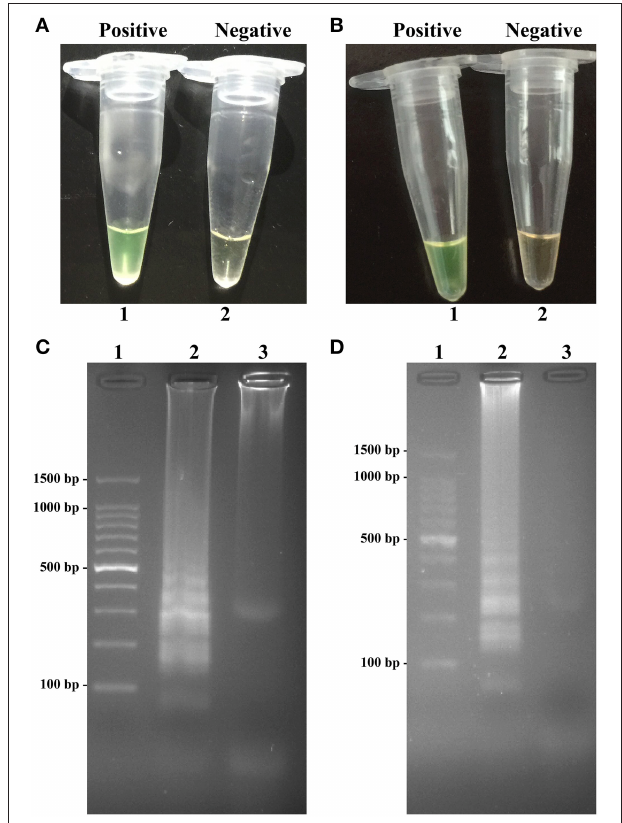
FIGURE 4 | Confirmation and detection of ipaH - and invA -MERT-LAMP products. (A,B) Color change of ipaH - and invA -MERT-LAMP tubes; tube 1, positive amplification; tube 2, negative amplification. (C,D) 2% agarose gel electrophoresis applied to ipaH - and invA -MERT-LAMP products; lane 1, DL 100-bp DNA marker; lane 2, positive LAMP reaction, lane 3, negative LAMP reaction.